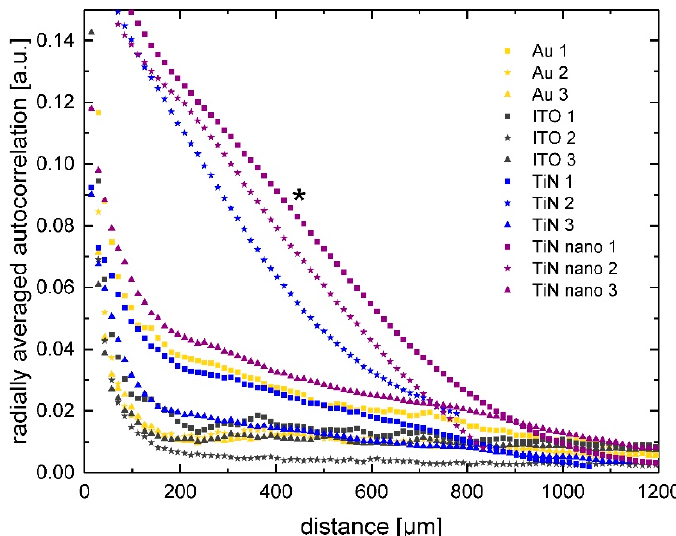
Figure 4. Radially averaged autocorrelation function of cell nuclei positions of SH-SY5Y neuronal cells after 3 days of culture on various substrate materials. The experiment and data points marked with * serves as an example of the K-means cluster analysis shown in Figures 5 and 6.